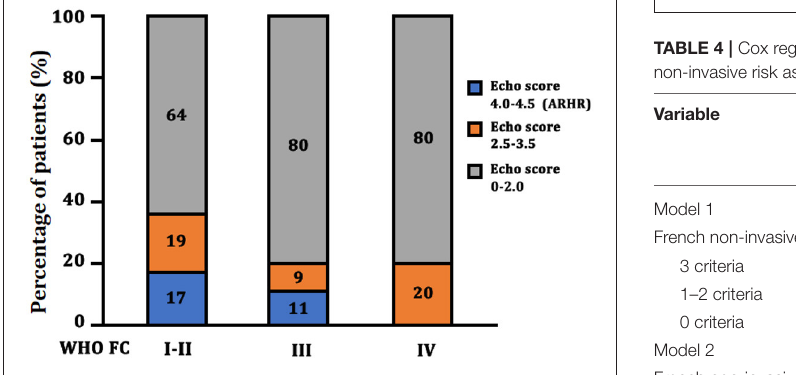
FIGURE 4 | Echo score in different WHO FC group at the follow-up assessment. ARHR, attenuated right heart remodeling; Echo, echocardiography; WHO FC, World Health Organization functional class.